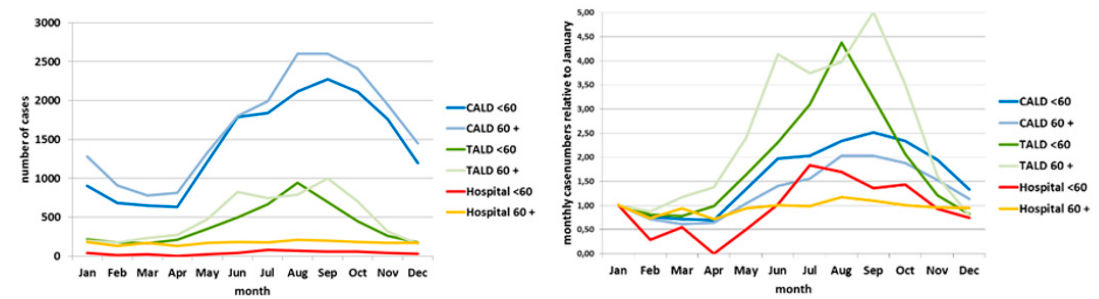
Figure 3. Left panel: absolute case numbers by month and exposure category, EU/EEA; European Center for Disease Prevention and Control (ECDC) “The European Surveillance System” (TESSy) data 2005–2015. Right panel: monthly case numbers (relative to January) by month and exposure category, EU/EEA; ECDC TESSy data 2005–2015.